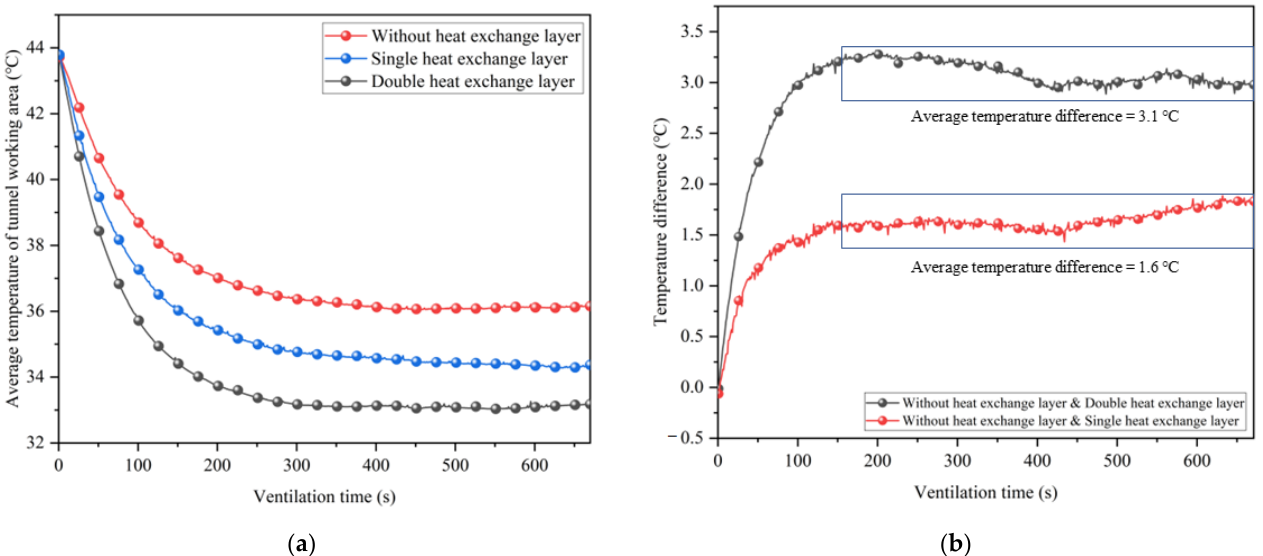
Figure 11. Comparison of the average temperature in the working area of different types of heat exchange layers: ( a ) Average temperature; ( b ) Temperature difference.